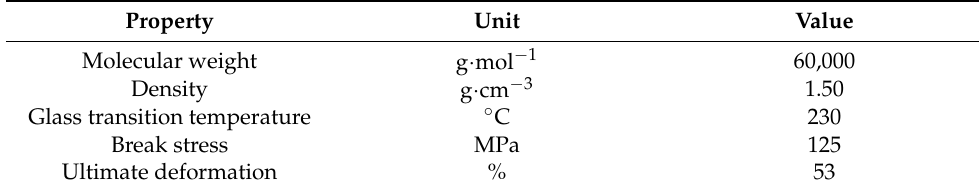
Table 2. Physical and mechanical properties of PAI